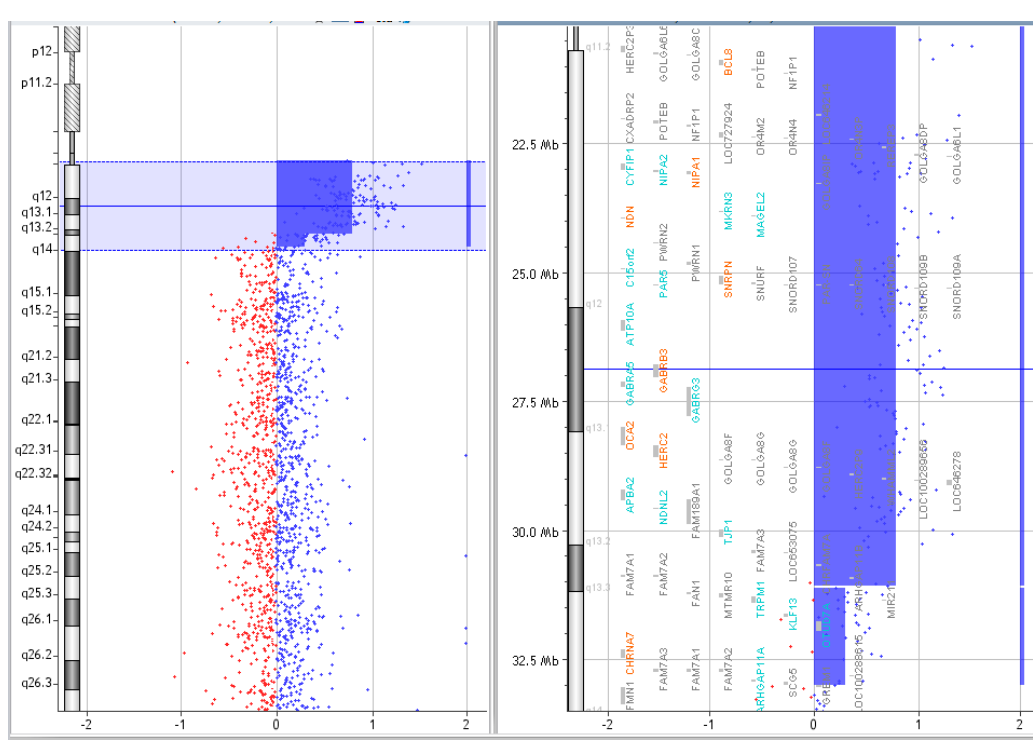
Figure 6. Array CGH results of P.5.